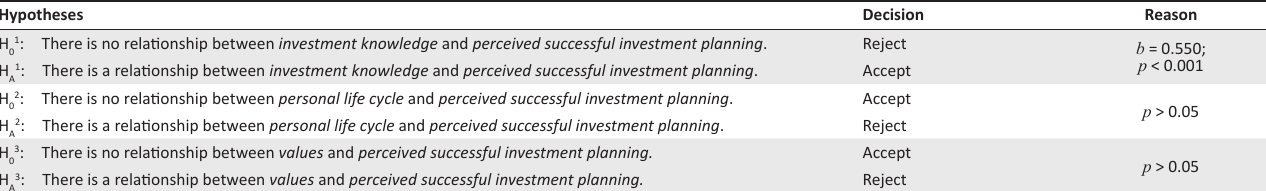
TABLE 6: Summary of acceptance of formulated hypotheses.